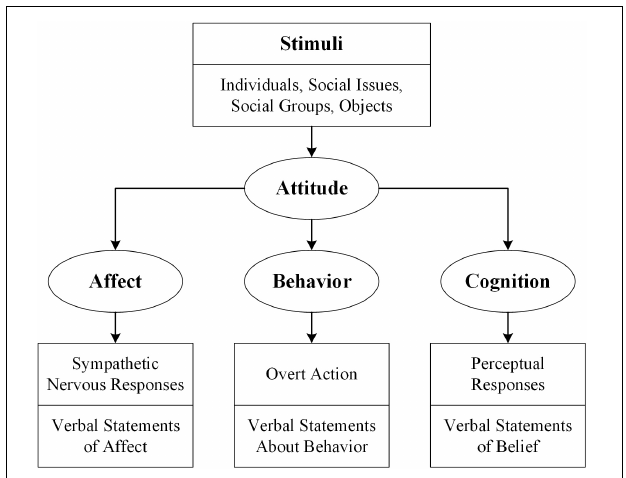
FIGURE 1 | The tripartite model of attitude